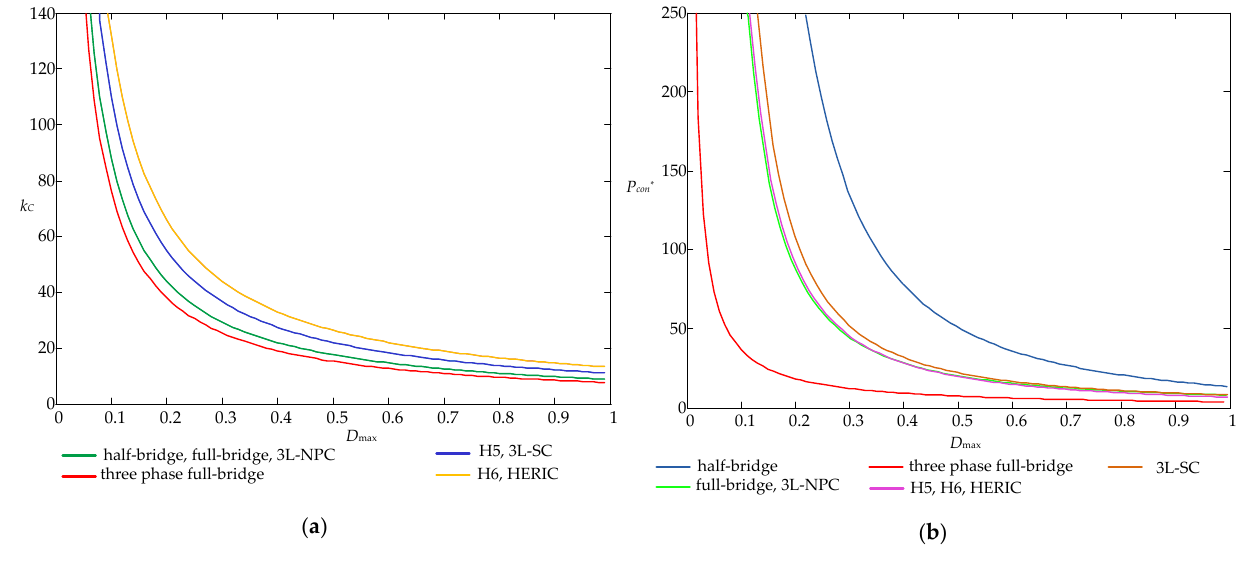
Figure 11. DC – AC converters: ( a ) cost factor k C ; ( b ) normalized power loss P con * . Because of a larger number of transistors, DC – AC converters are weaker in terms of parameter values k С and P con * than their DC – DC counterparts. Among DC – DC converters, the most effective solutions are based on buck and boost converters. Whereas buck-boost solutions (buck- boost, SEPIC, Cuk’ converters) increase cost s and losses. interleaved con- verters allow for reduced losses at the expense of an increase in price and dimensions.